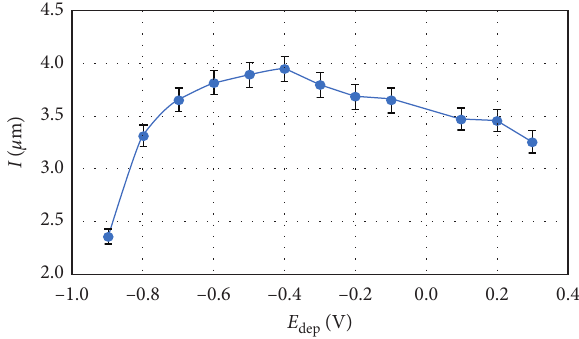
Figure 6: Effect of deposition potential ( E dep ) on the anodic stripping peak current of 0.05mg l − 1 Hg 2+ in 0.05mol L − 1 HCl, t dep � 30s, and sweep rate 0.04 Vs − 1 Figure 8: Anodic stripping differential pulse voltammograms for increased concentrations of mercury spiked in solid samples: (1) blank; (2) 10 µ gL − 1 ; (3) 30 µ gL − 1 ; (4) 50 µ gL − 1 ; (5) 100 µ g L − 1 ; (6) 150 µ g L − 1 ; E dep �− 0.5 V, t dep � 40 s, sweep rate 40mVs − 1 , pulse amplitude 50mV, pulse time 40ms, and 0.05 molL − 1 HCl.